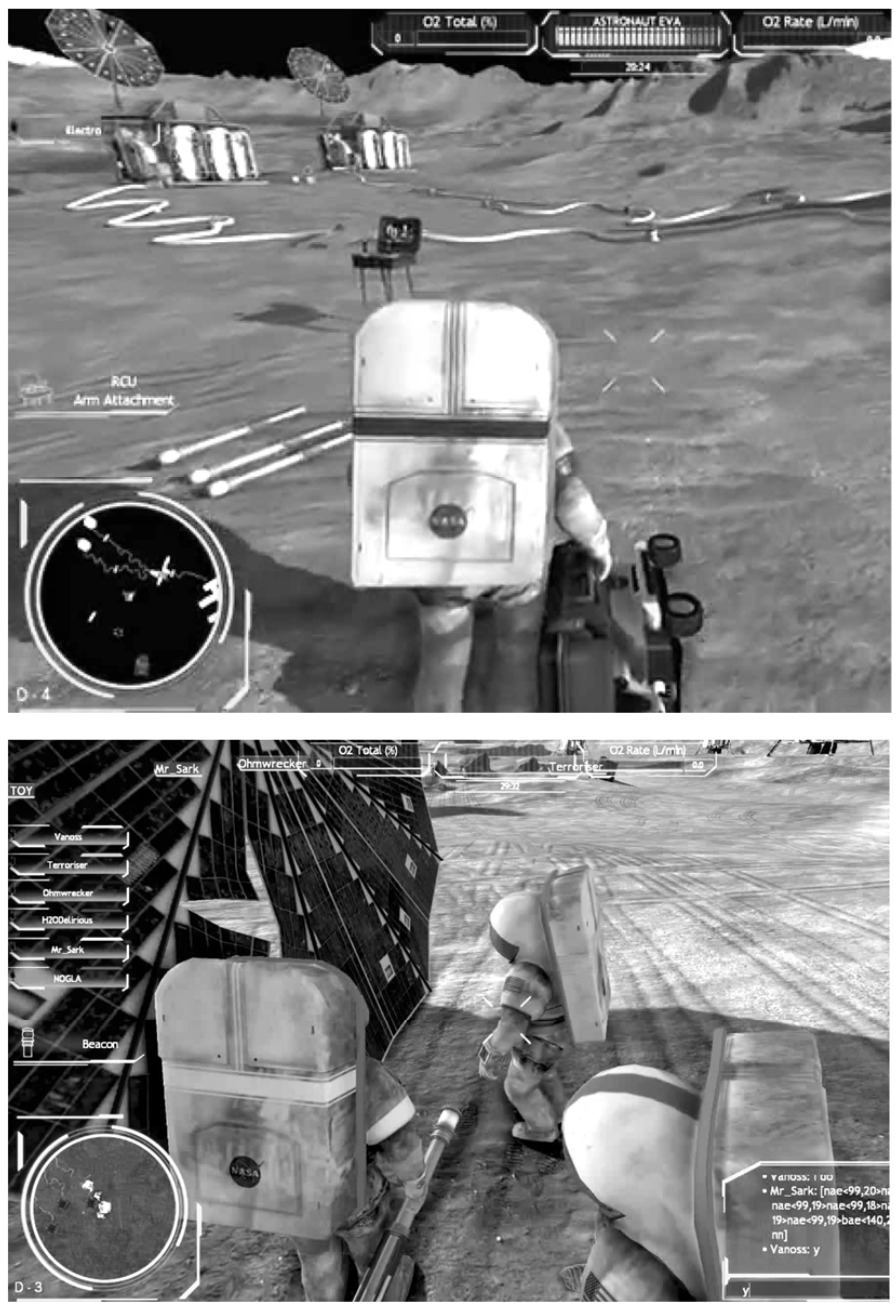
Figure 1. Screenshots of the game Moonbase Alpha with both the single player ( upper panel) and multi ‐ player ( lower panel) modes shown.